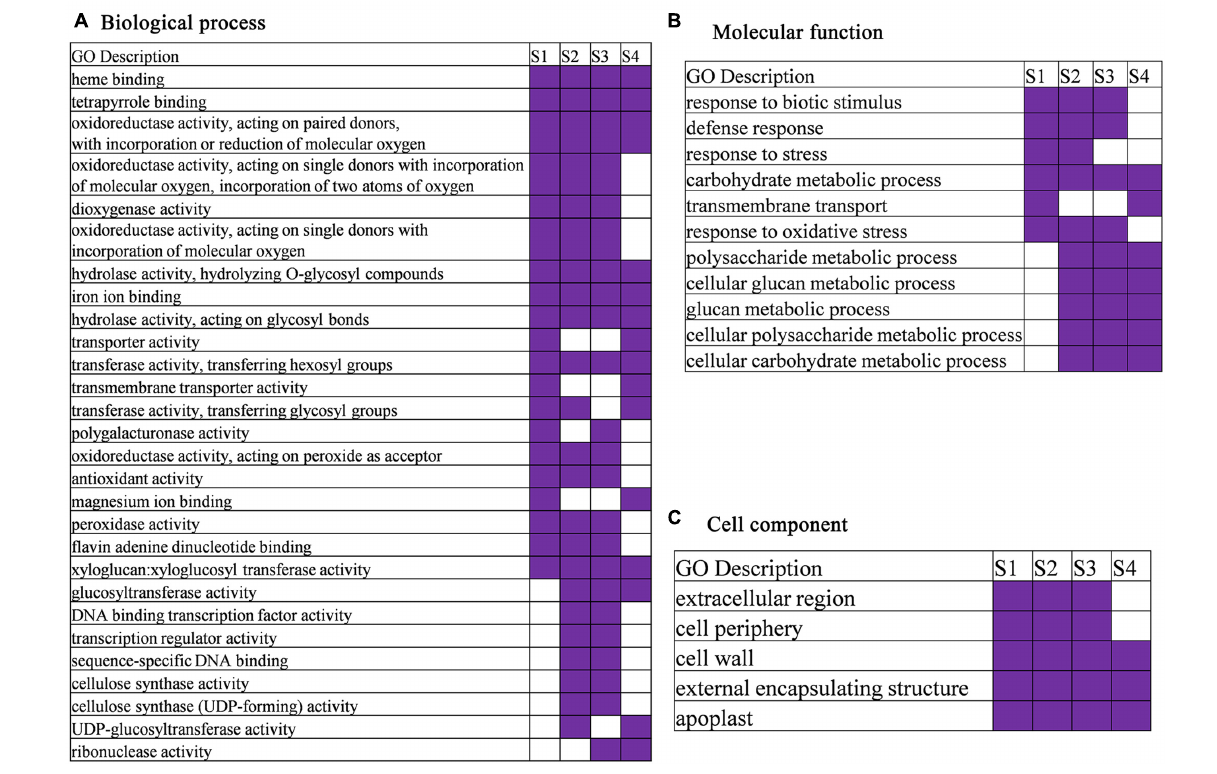
POD, and MDA present difference in anther between CK and